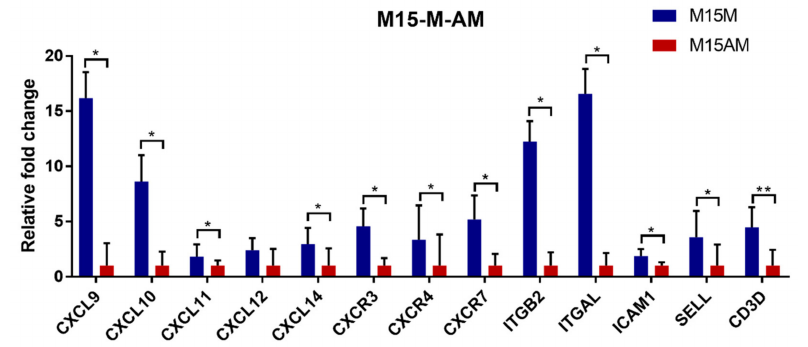
Figure 5. Validation of the di ff erentially expressed genes between the mesometrial and anti-mesometrial side of the uterus at gestational day 15 by qRT-PCR. The error bars show the SD. The p -value was calculated using the t -test. * p < 0.05; ** p < 0.01. M15M, gestational day 15 at the mesometrial side of the uterus; M15AM, gestational day 15 at the anti-mesometrial side of the